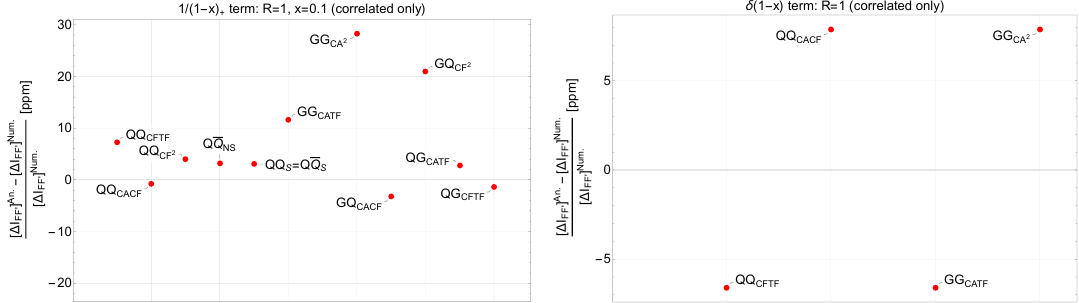
Figure 2 . Difference, in parts per million, between the analytic result and the numerical calculation with full R dependence for the correlated contribution to the unsubtracted beam functions. The figures show the coefficient of 1 / (1 − x ) + at x = 0 . 1 (left plot) and the coefficient of δ (1 − x ) (right plot), both evaluated at R = 1 . The different labels denote the various colour structures contributing to each flavour channel. The size of the difference is always at the level of the precision of the numerical